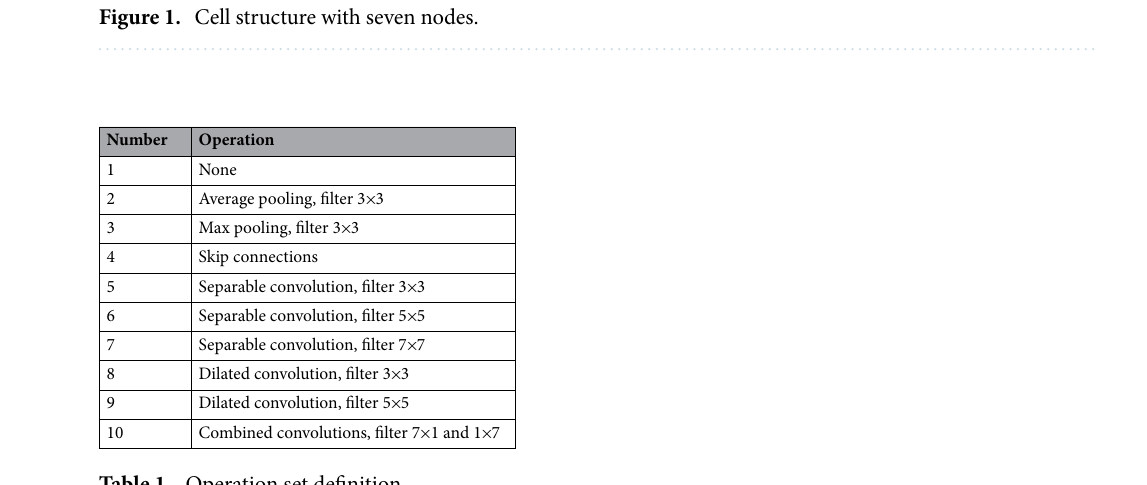
Table 1. Operation set